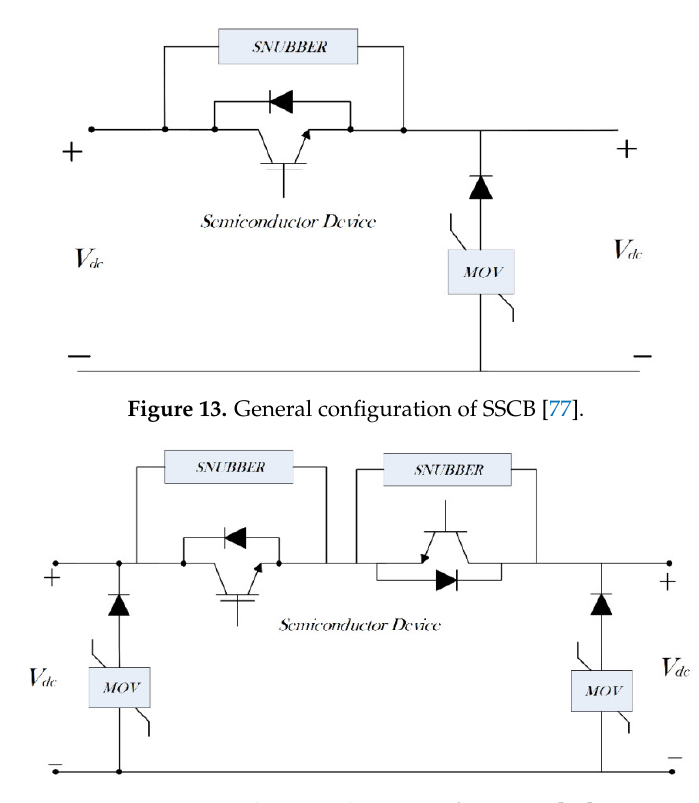
Figure 14. Bi-directional SSCB configuration [81].